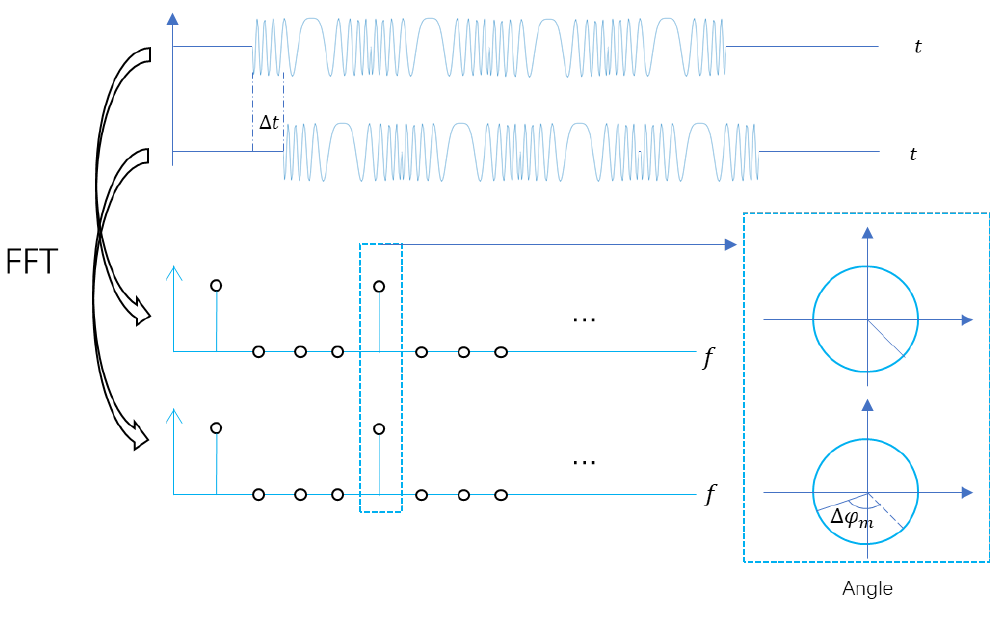
Figure 3. Relationship between phase shift and time delay.